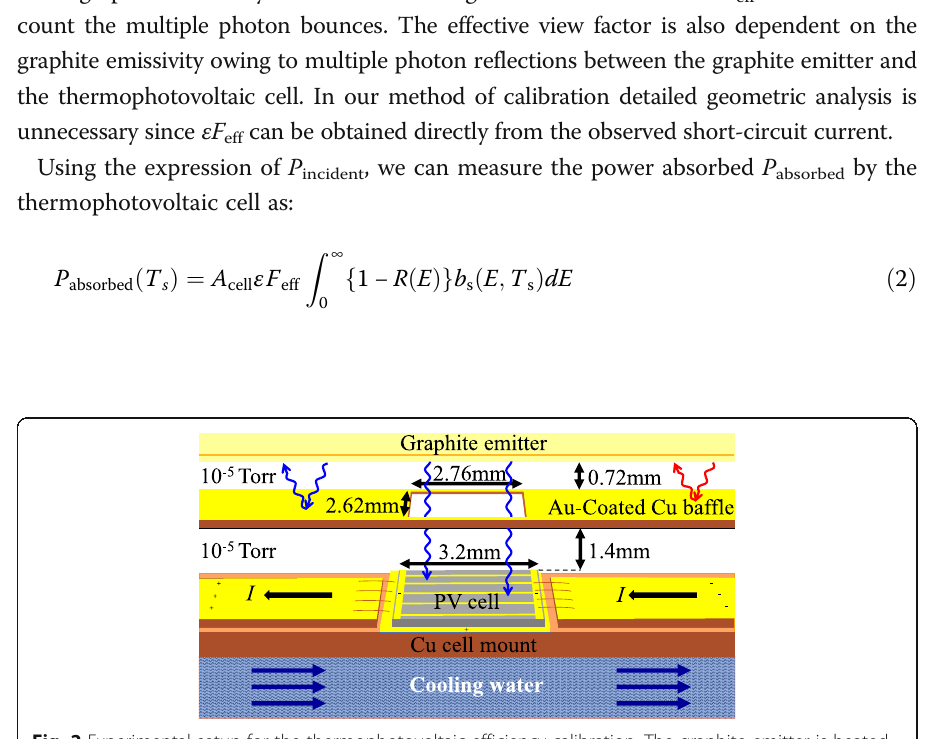
Fig. 2 Experimental setup for the thermophotovoltaic efficiency calibration. The graphite emitter is heated by Joule heating. The cell sits under a baffle, to minimize any stray photons reaching the cell. The wire bonds are made separately, to the top and bottom electrodes, for electrons and holes respectively. The cell is cooled to a standard temperature, 25 °C. Current ( I ) and voltage are measured by wire-bonding the cell to electrical